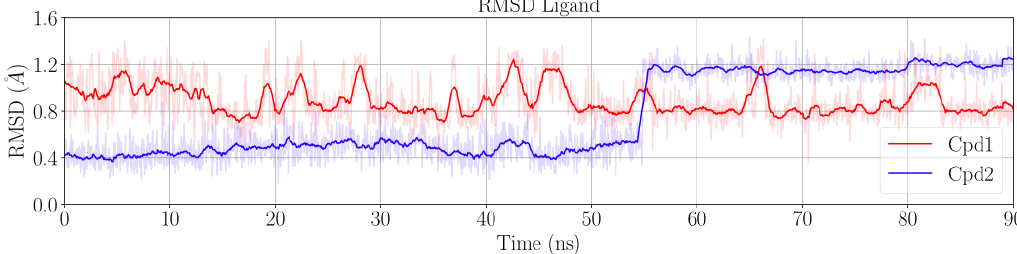
Figure 2. Time evolution of the root-mean square deviation (RMSD) of Cpd1 ( red ) and Cpd2 ( blue ) computed on Sys1 and Sys2 trajectories, respectively.